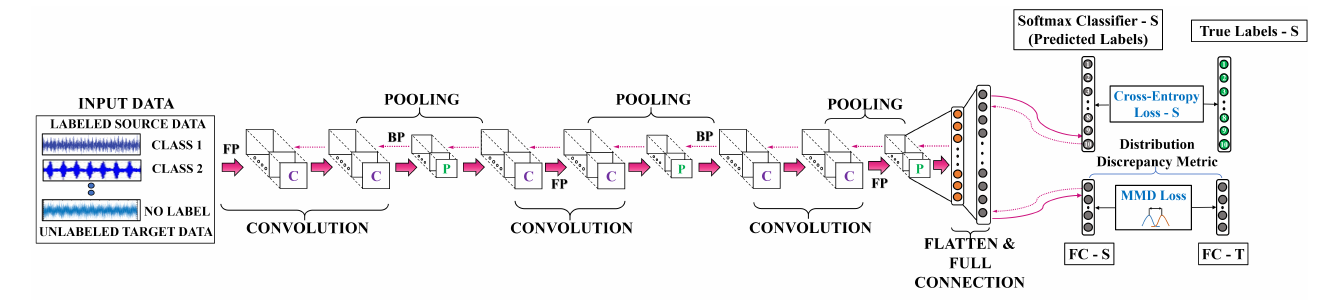
Figure 3. The proposed deep learning architecture for cross-domain fault